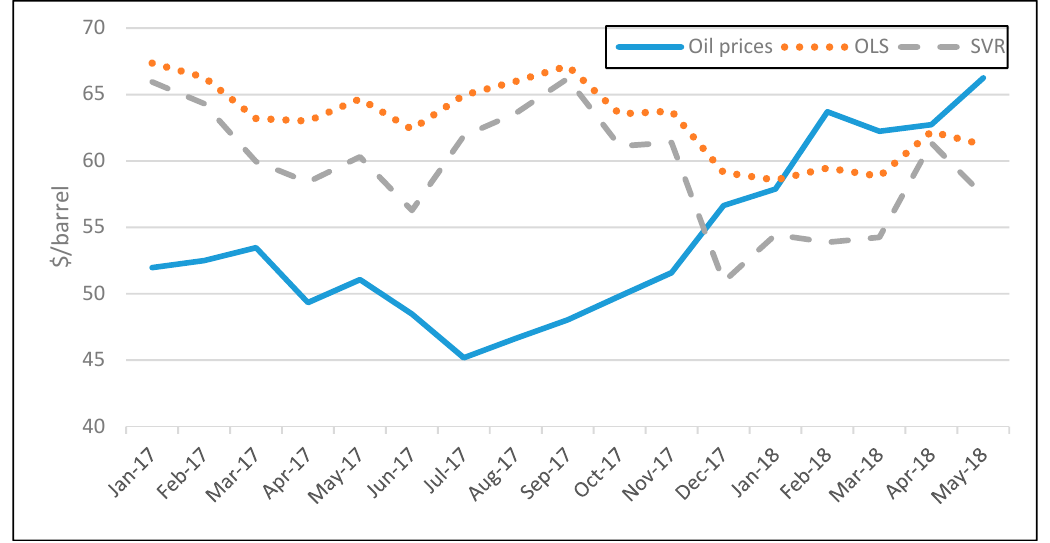
Figure 3. Out-of-sample 12-month ahead oil prices forecasts based on the Saudi Arabia GPR index for the SVR and OLS model for the period Jan-2017 to May-2018.